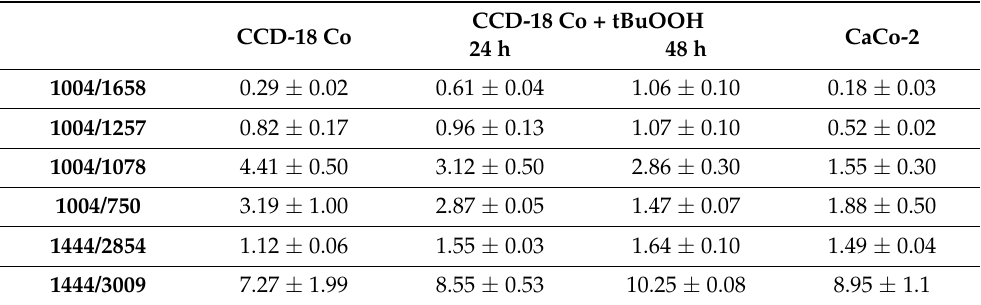
Table 2. Raman band intensities ratios for selected Raman bands corresponding to proteins, nucleic acids, and lipids for human normal colon cells CCD-18 Co in normal conditions, in oxidative stress conditions generated by adding tBuOOH and for cancerous human colon cells